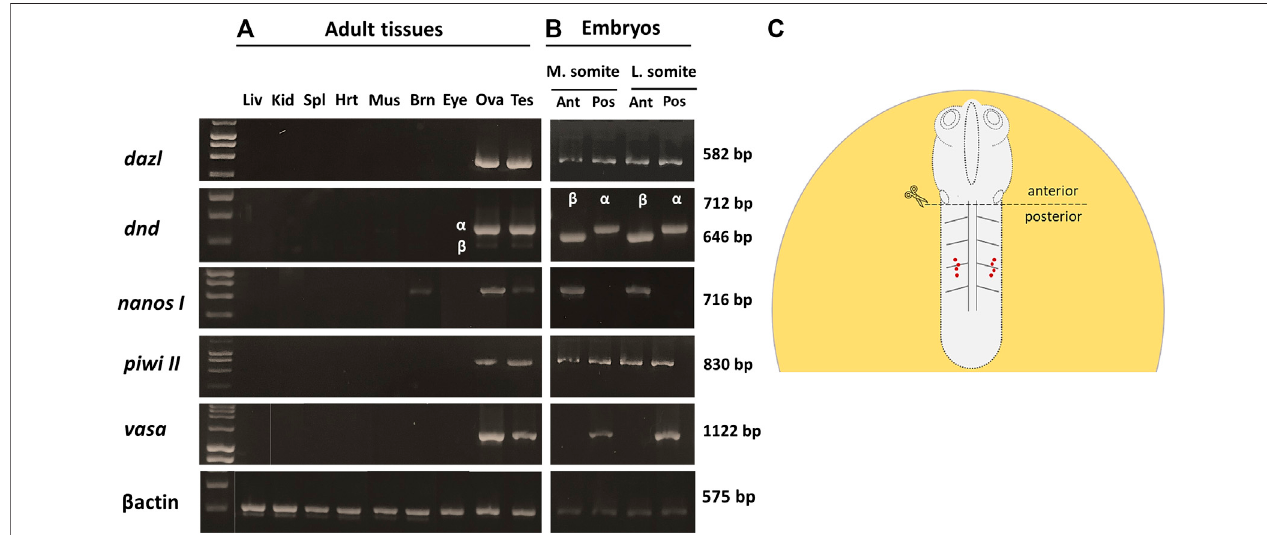
FIGURE2| Thespatio-temporalexpressionofPGCmarkersinpre-andpostnatal G.holbrooki .Photomicrograph,showingtheexpressionofPGCmarkergenesin adulttissues,75 dayspostparturition (A) andembryosatmid-somitestage (B) .Genenamesandtheampliconsize,inbasepairs(bp)areindicatedontherightandleftof the panel respectively. β actin was used as endogenous reference. The schematic (C) shows anterior and posterior partitioning of the somite stages embryos for RNA extraction and end-point PCR assay. The red dots (C) show the location of migrating PGCs in mid-segmentation embryos. Liv, liver; Kid, kidney, Spl, spleen; Hrt, heart; Mus, skeletal muscle; Brn, brain; Eye, eyes; Ova, ovary; Tes, testis; M. somite, mid-somitogenesis; L. somite, late somitogenesis; Ant, anterior; Pos,